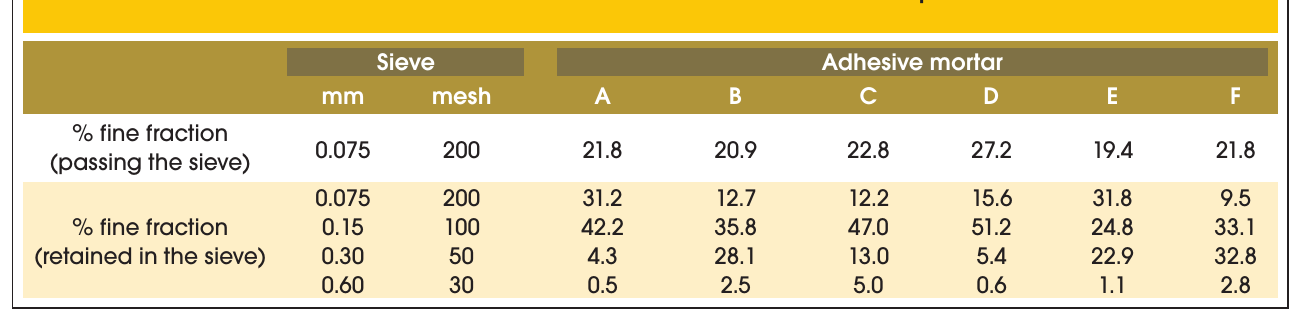
Table 3 – Percent of material retained and Percent of material pass on